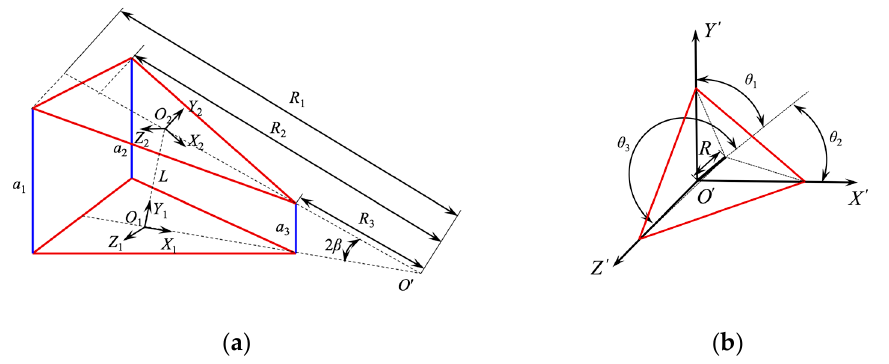
Figure 6. Simplified structure of the scissor mechanism unit. ( a ) Stretch structure simplification. ( b ) Deflection structure simplification.